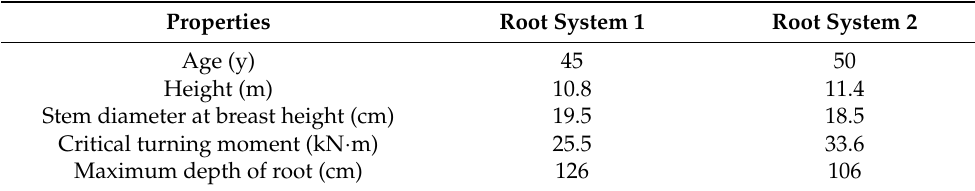
Table 1. Properties of Pinus thunbergii